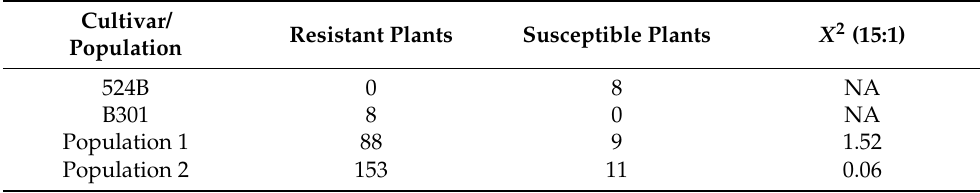
Table 2. Alectra vogelii resistance of cowpea lines 524B, B301, and F 2 progeny (524B × B301). Chi- squared ( X 2 ) analysis of F 2 phenotypic segregation was performed based on an assumption of duplicate dominant unlinked genes.